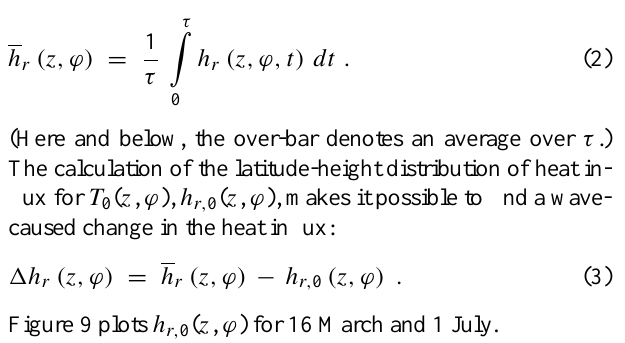
Figure 9 plots h r, 0 ( z , ϕ ) for 16 March and 1